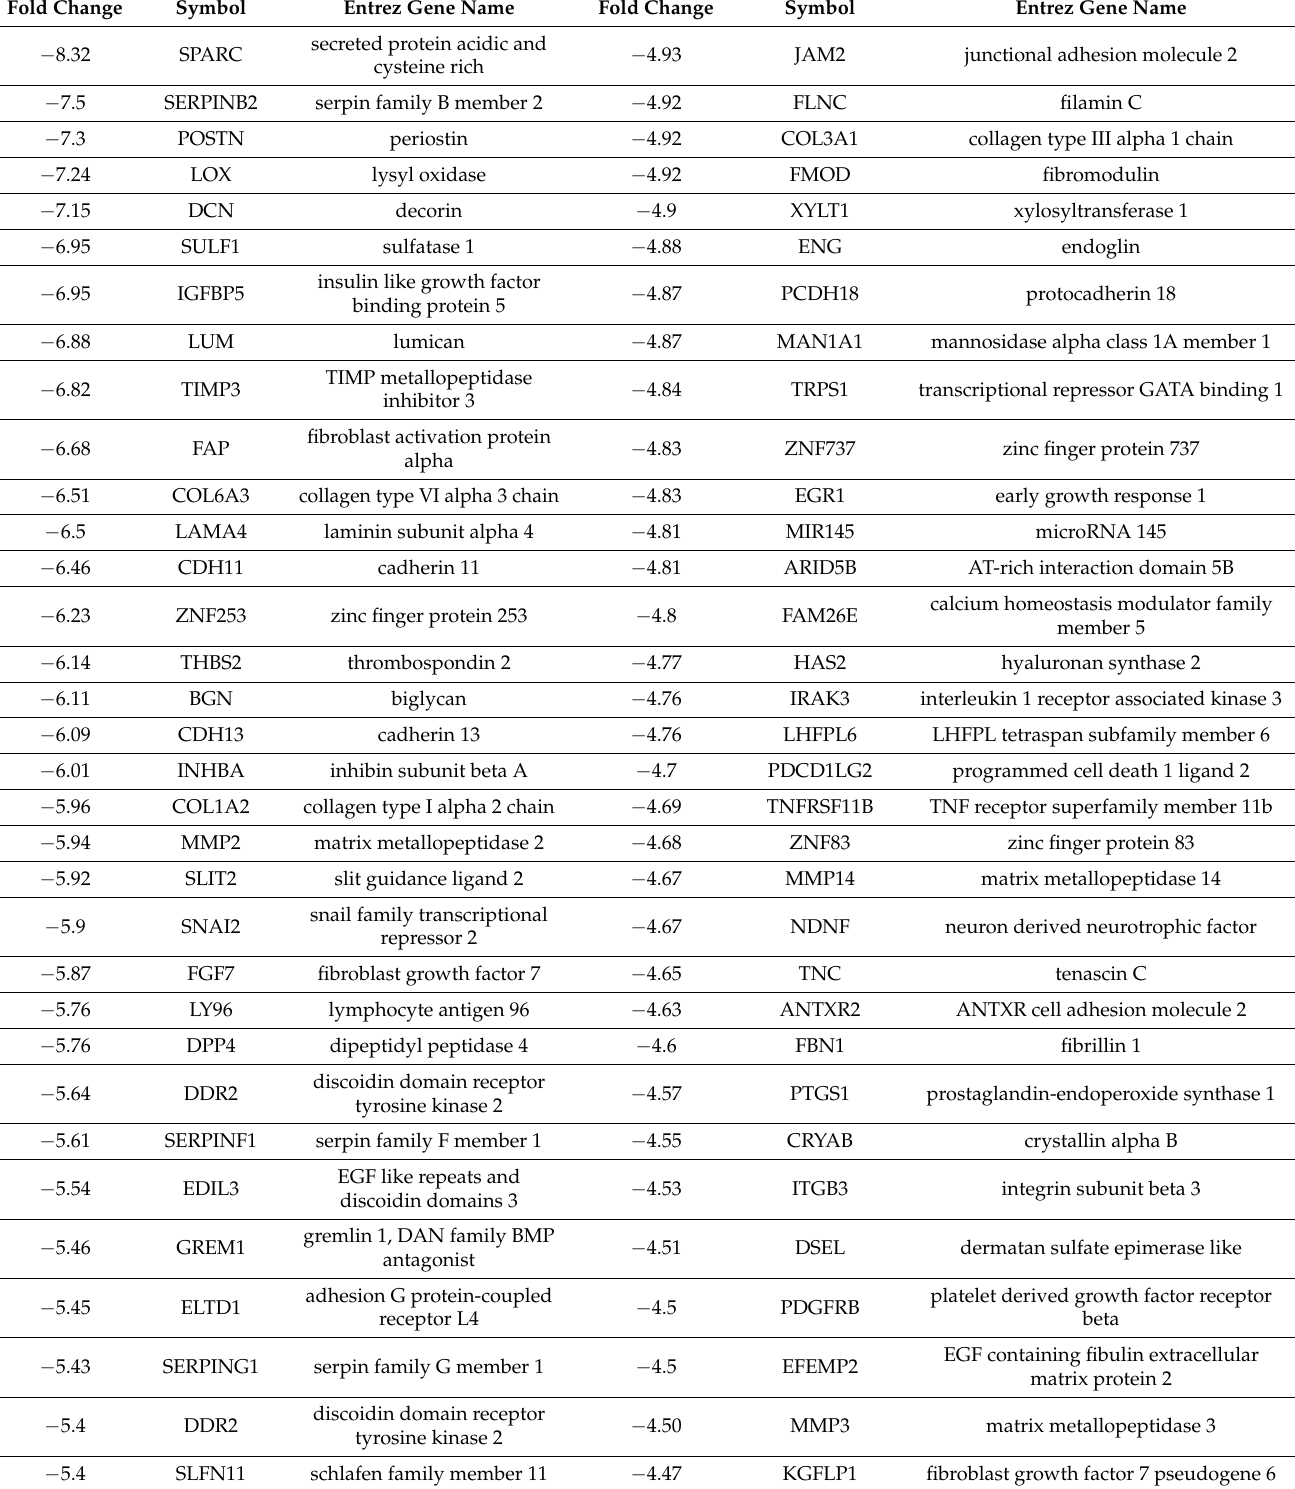
Table 2. The 100 most downregulated genes expressed by ELC after the MET from human lung fibroblasts are listed. Fold change for each gene is indicated; symbol and gene name are in progressive order of